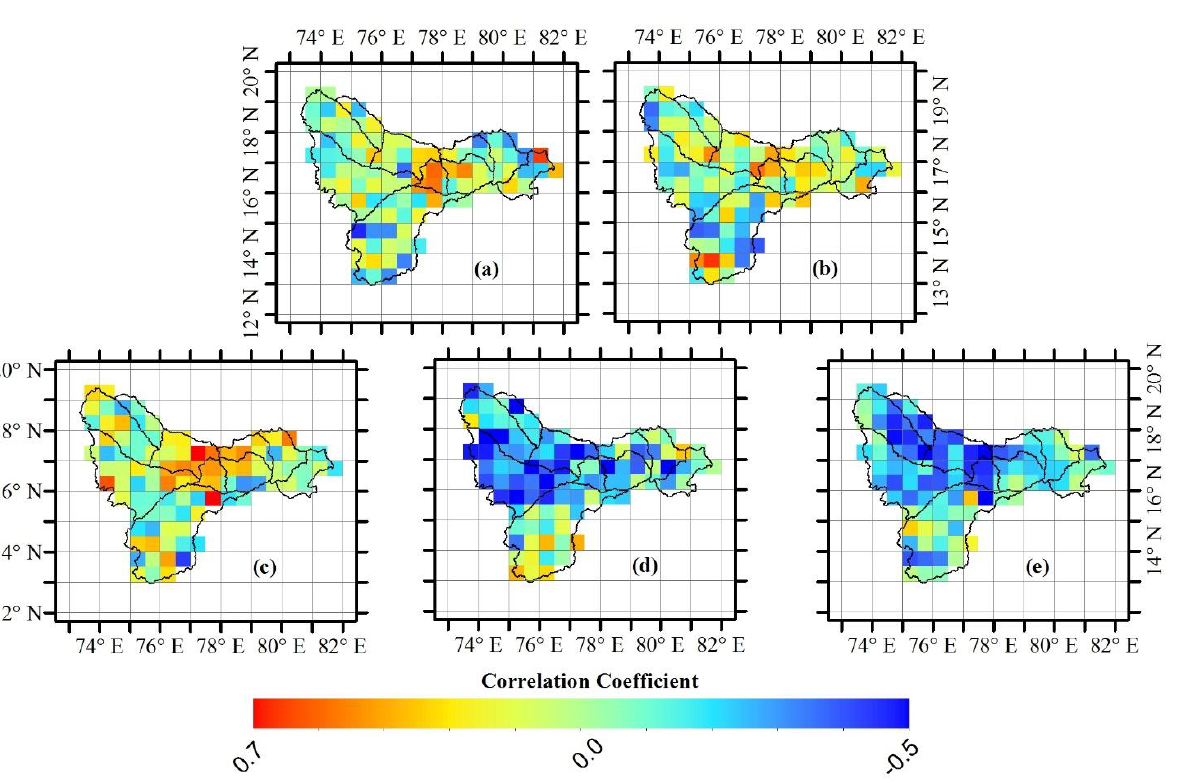
Figure 4. Depicts spatial pattern of correlation coefficient between groundwater and (a) Relative entropy, (b) Seasonality Index, (c) Time for peak monsoon, (d) Evapotranspiration, (e) Duration of wet